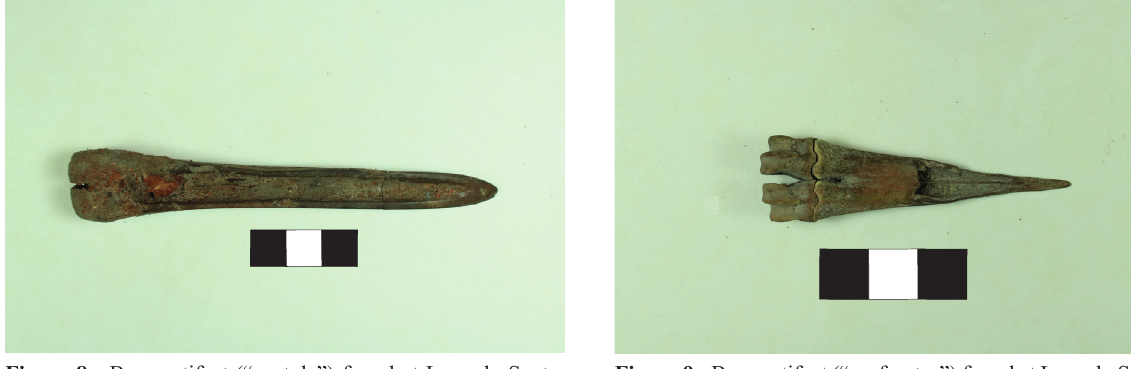
Figure 9 - Bone artifact (“perforator”) found at Lapa do Santo. Piece St-2439.